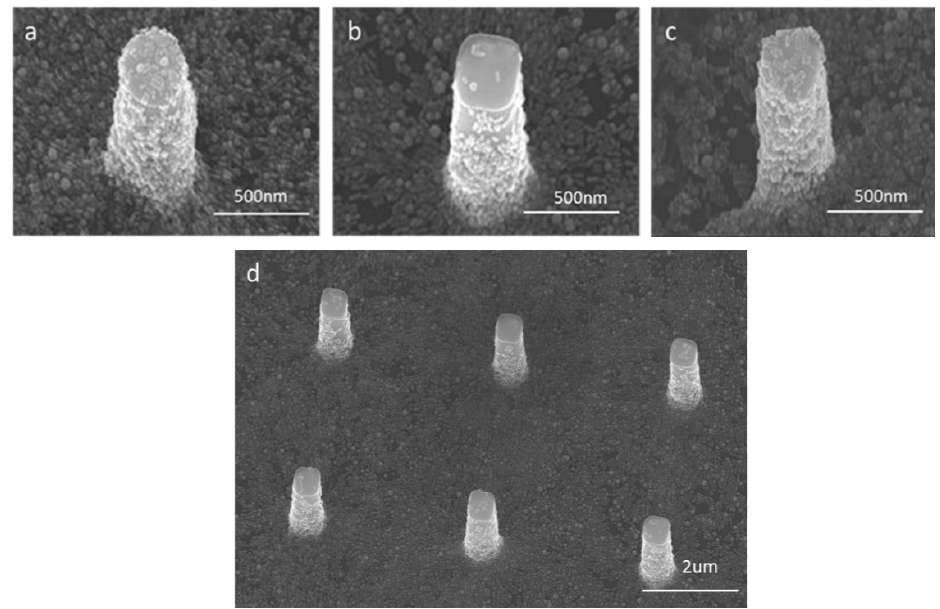
Figure 7. SEM images of different shaped AuNR-functionalized TiO 2 and SiO 2 -TiO 2 nanopost arrays. ( a ) spheres, ( b ) squares, ( c ) triangles, ( d ) square arrays.